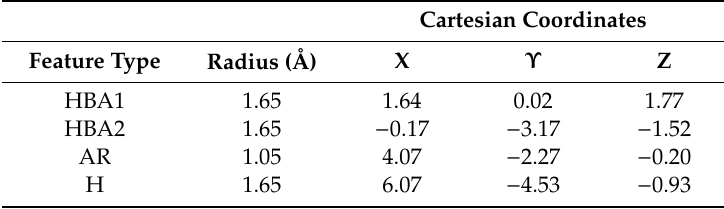
Table 1. Pharmacophore features coordinates and tolerance radii (Å) of the optimized pharmacophore model.